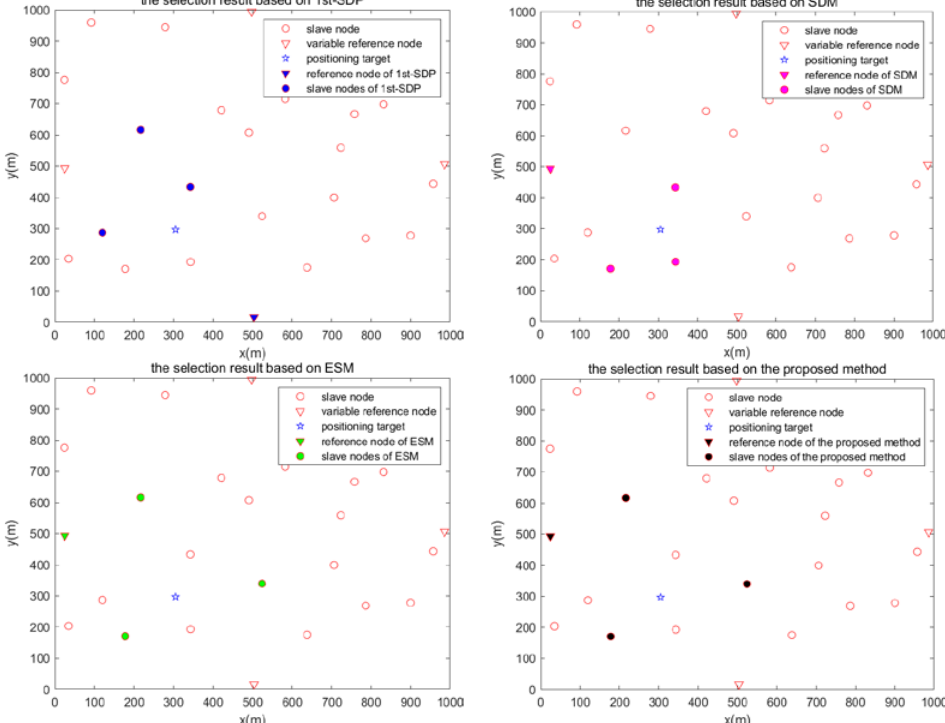
Figure 8. Optimal results of node selection using different methods.